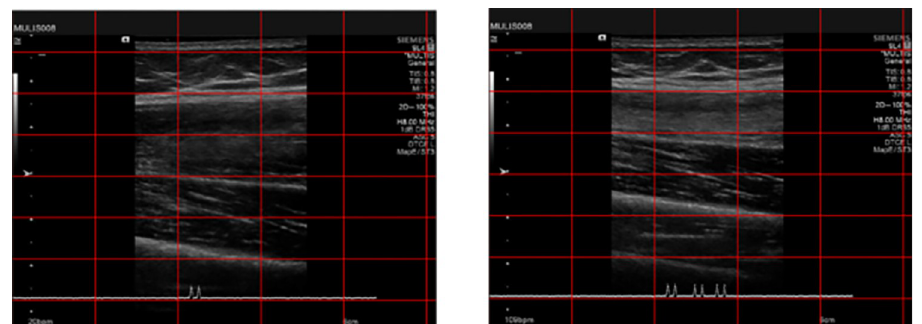
Fig 2. Ultrasound images of female upper leg. The thickness of the tissue (unloaded image on the left, loaded on the right) changes as force is applied by the instrumented ultrasound probe from a starting force of 0.14 N to an end force at 9.93